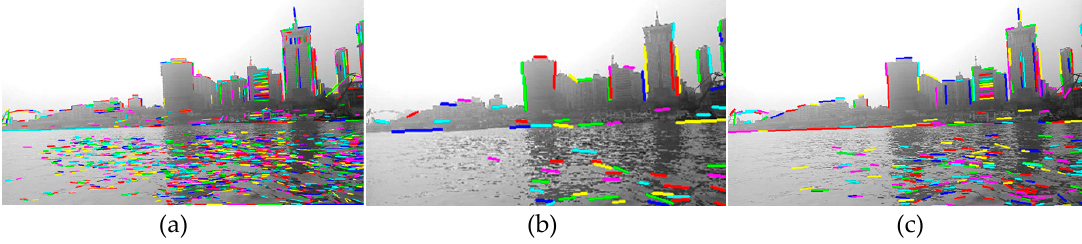
Figure 3. The relationship between the image resolution and the number of line segments: ( a ) the image resolution is 1280 × 720 px, and a large number of line segments are detected; ( b ) the image resolution is 320 × 180 px, and many line segments are lost in the image; ( c ) the image resolution is 640 × 360 px, and the number of line segments in the image is more appropriate.